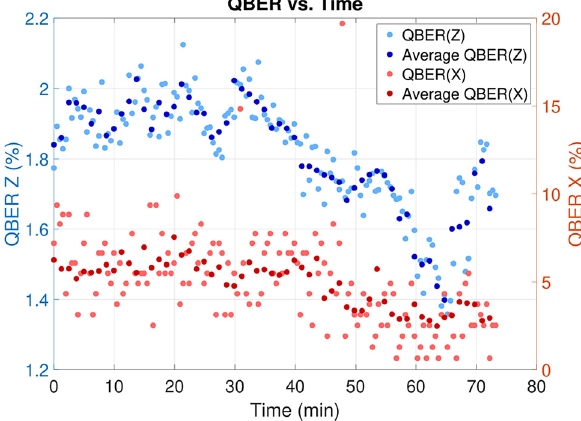
Figure 5: Stability of the QKD system. The graph represents variation of QBER measured in the X and Z basis for a duration of approximately 75 min. The averaging points represent average QBER obtained every 75